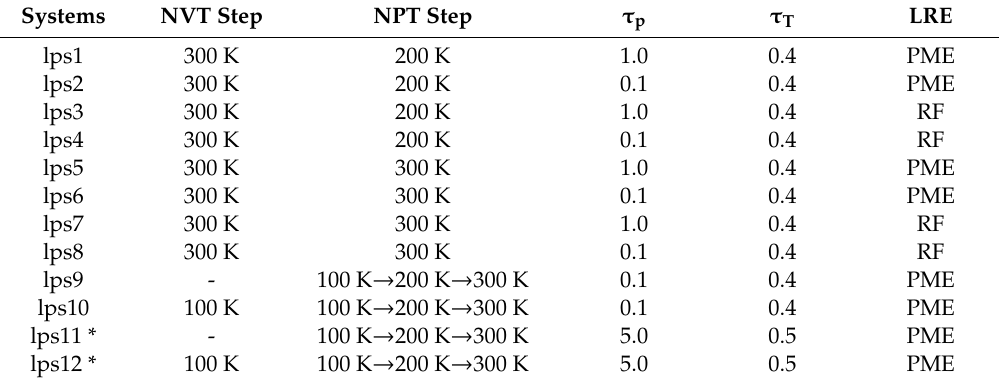
Table 1. Molecular dynamics (MD) simulations of LPS / DPPE membranes using the NVT / NPT equilibration protocol and di ff erent barostats, thermostats, and long-range electrostatic (LRE) approximations. Pressure ( τ p ) and temperature ( τ T ) coupling constants in ps. Simulations were performed in